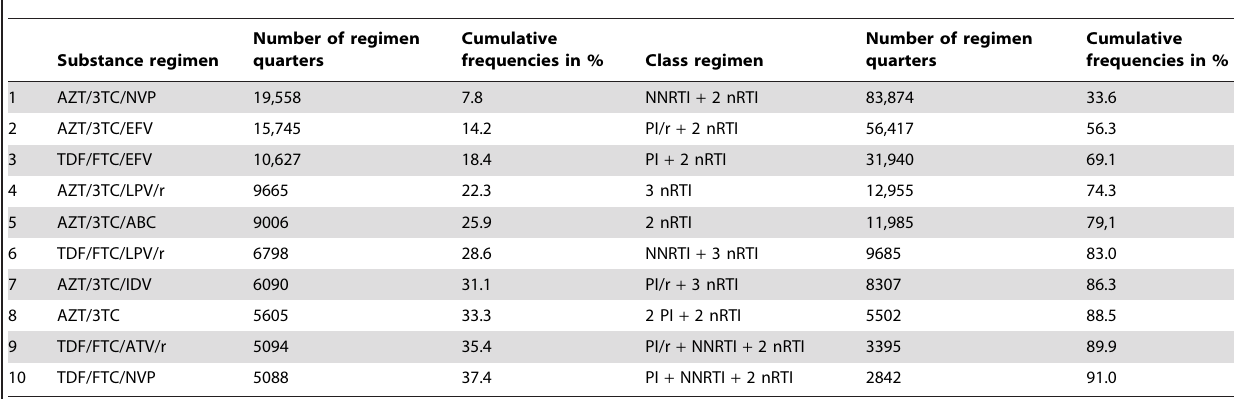
Table 3. Top ten antiretroviral substance regimens (n= 2226) and class regimens